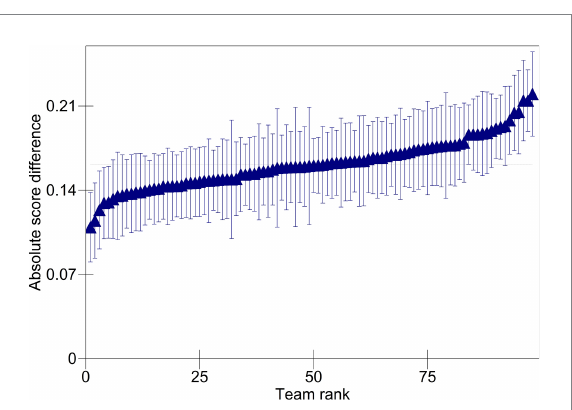
FIGURE 2 Predicted absolute score differences for teams.